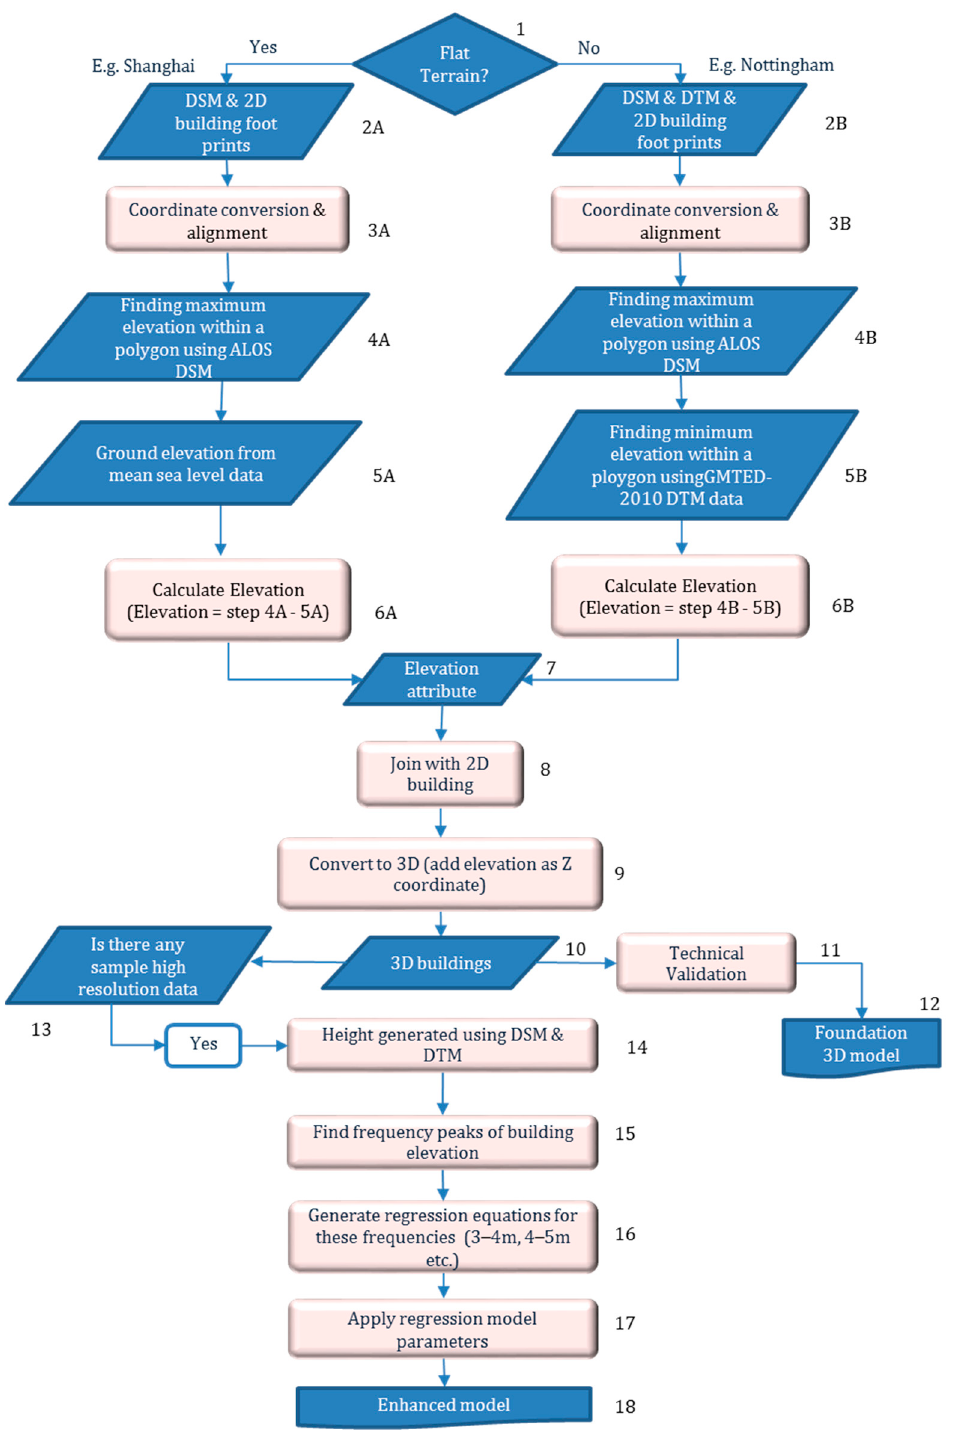
Figure 2. Overall methodology. Blue boxes indicates important steps and pink colour indicates intermediate steps.